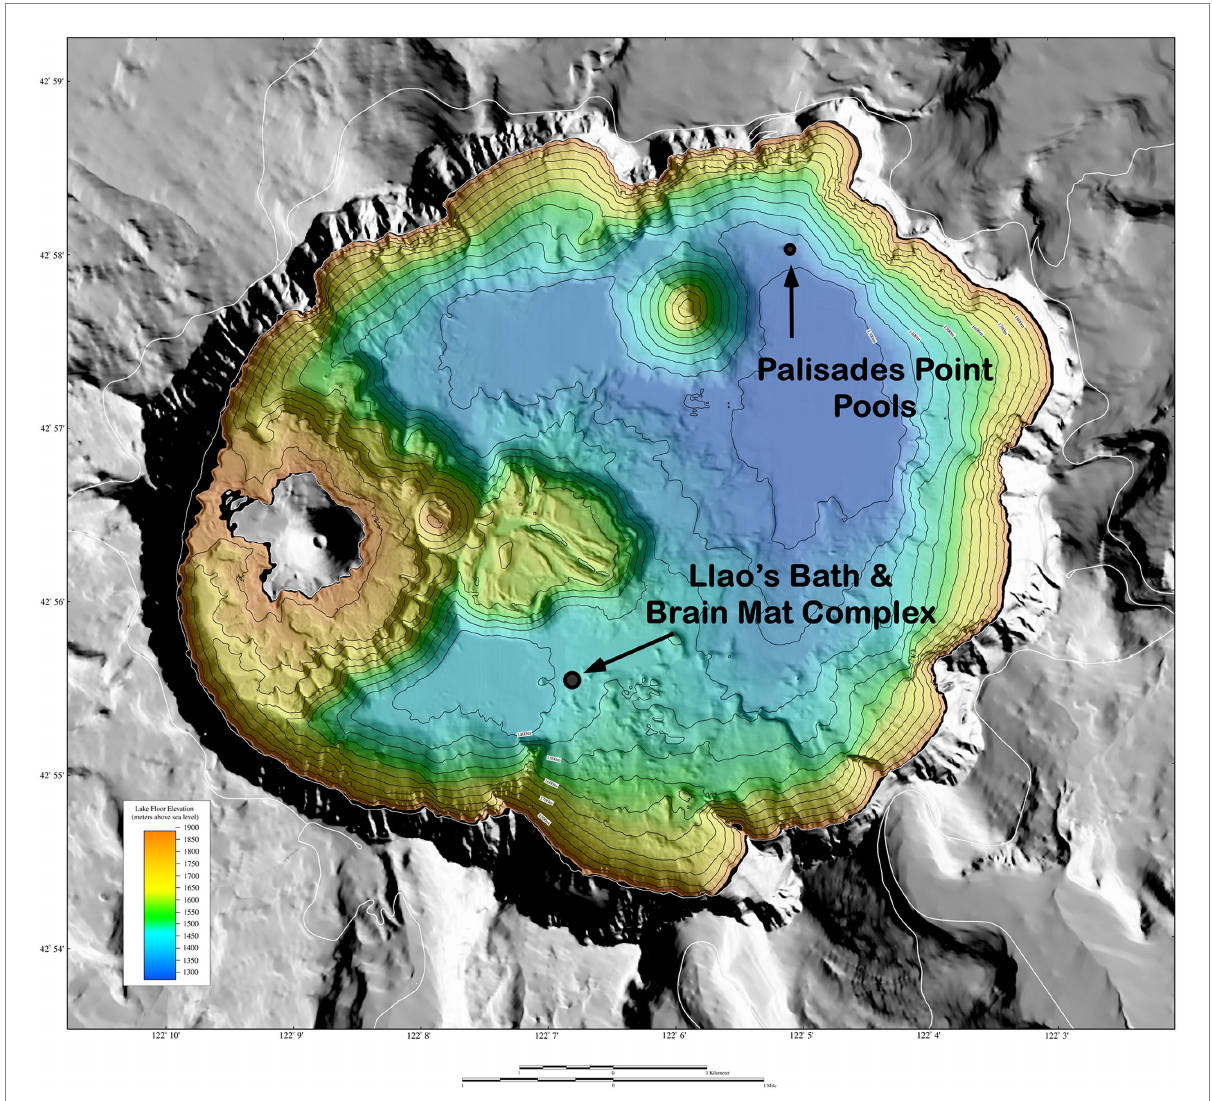
FIGURE 1 Shaded relief of surrounds and bathymetric map of the floor of Crater Lake, Oregon. Surrounding terrain from USGS 10 m digital elevation model (DEM). DEM illuminated from 225 ° azimuth, 45 ° elevation. Colored region is the lake floor (±1 m resolution), whereas the gray region is the surrounding land. The distance across the width of the lake is approximately 9 km (5.6 miles). The reds and yellows show the shallower depths of the lake, whereas the greens and blues show the deeper depths. Adapted from Bacon et al.,